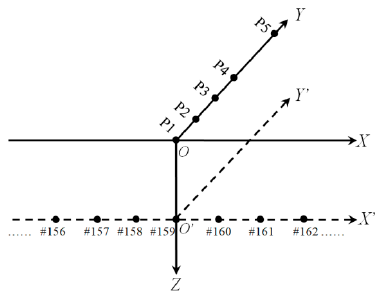
Figure 10. Coordinate system defined for the analysis of influence range of the simulated intrusion.